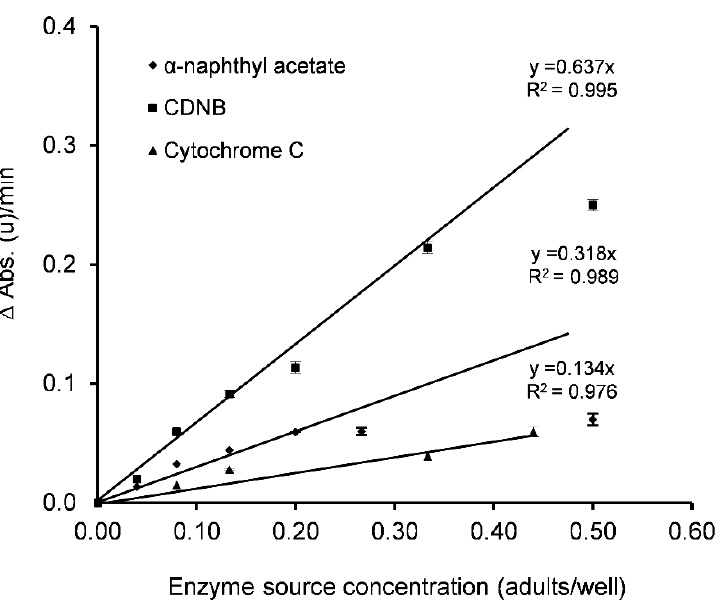
Figure 3. Influence of enzyme source concentration on reaction rates (ΔAbs.(u)/min) with the three respective substrates (α-naphthyl acetate, CDNB and cytochrome C). Error bars correspond to standard error (total number of insects tested, α-naphthyl acetate: n = 56, CDNB: n = 28, cytochrome n = C: n = 24).